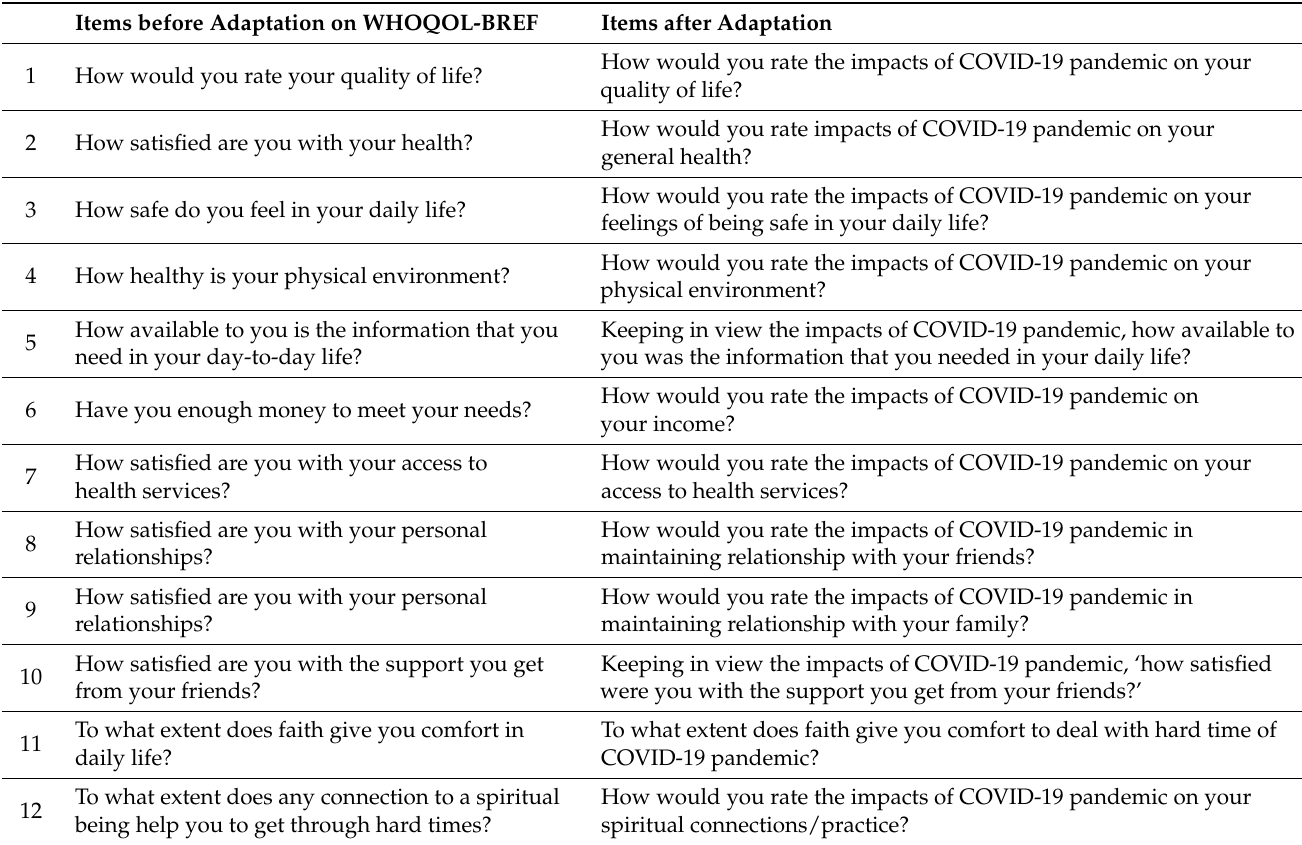
Table 1. The list of items adapted to assess QoL in the context of the COVID-19 pandemic. Items before Adaptation on WHOQOL-BREF Items after